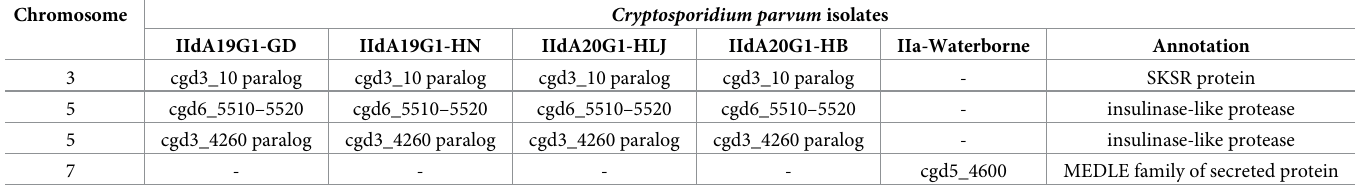
Table 2. Copy number variations in subtelomeric genes between IIa and IId isolates of Cryptosporidium parvum .